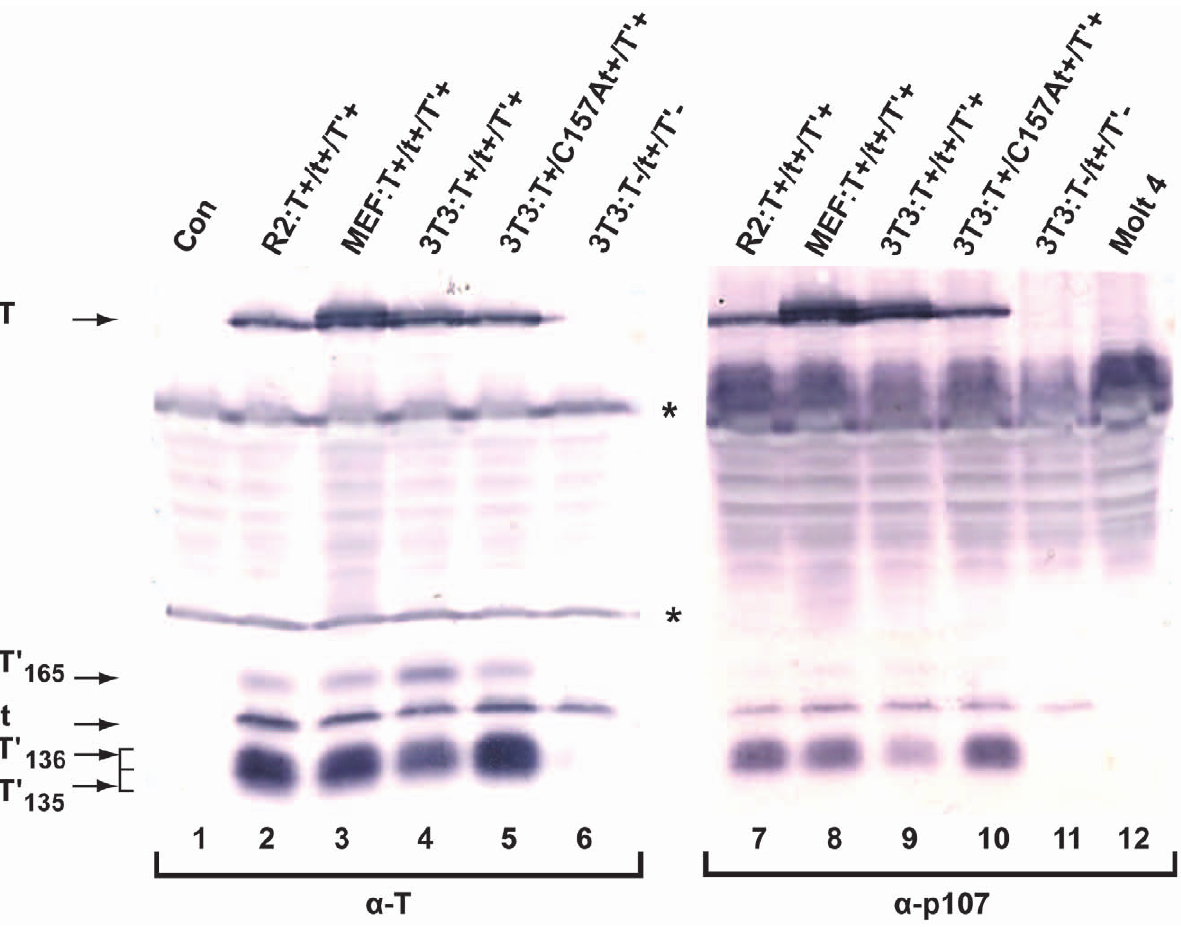
Figure 4. Wild type and mutant JCV tAgs bind the Rb protein p107. JCV early proteins expressed in Rat 2 (R2) or MEF cells transformed with pSR:T + /t + /T’ + (encodes all 5 JCV early proteins) or in G418-selected 3T3 cells stably transfected with pSR:T + /t + /T’ + , pSR:T 2 /t + /T’ 2 (encodes tAg only) or pSR:T + /C157At + /T’ + (encodes tAg mutated at residue 157 and the other 4 JCV early proteins) were incubated with anti-T monoclonal antibody PAb 962 ( a -T; lanes 2–6) or anti-p107 antibody ( a -p107; lanes 7–11). Negative controls included EBC lysis buffer immunoprecipitated with anti-T monoclonal antibody PAb 962 (Con, lane 1) and Molt 4 extract with anti-p107 antibody (Molt 4, lane 12). The amount of total cell protein subjected to IP in lanes 7–11 was 10 times that employed in the corresponding samples in lanes 2–6. Proteins were separated on an 18% SDS-polyacrylamide gel and WB analysis was performed using a cocktail of anti-T monoclonal antibodies. The asterisks denote antibody light and heavy chains. This figure represents proteins electrophoresed on a single gel and transferred to a membrane, which was then cut in half and each half developed for different lengths of time.